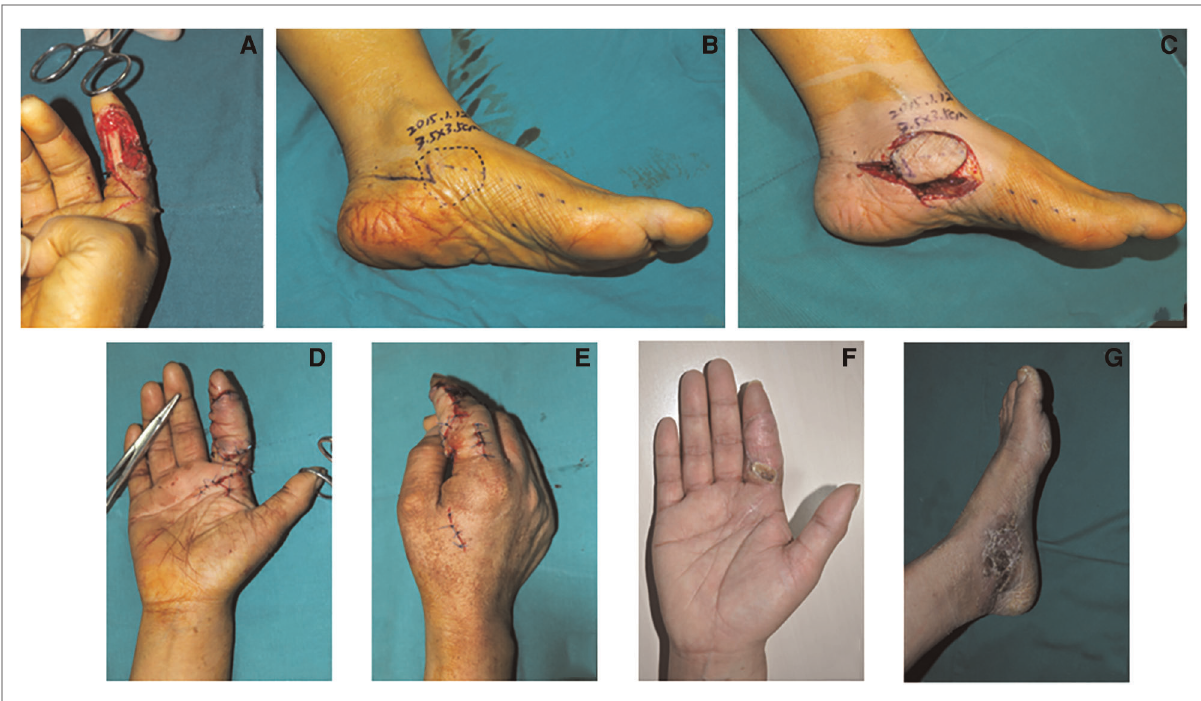
FIGURE 4 Case 3: The defect in the fi nger after debridement ( A ). An outline of an MPAP fl ap (3.5×3.5 cm 2 ) based on the perforators of the medial branch of the deep branch of the MPA is drawn ( B ). The MPAP fl ap is harvested ( C ). The appearance of a fi nger with the MPAP fl ap reconstruction ( D,E ). Follow-up at 3-month post-operative period ( F , fi nger and G , donor